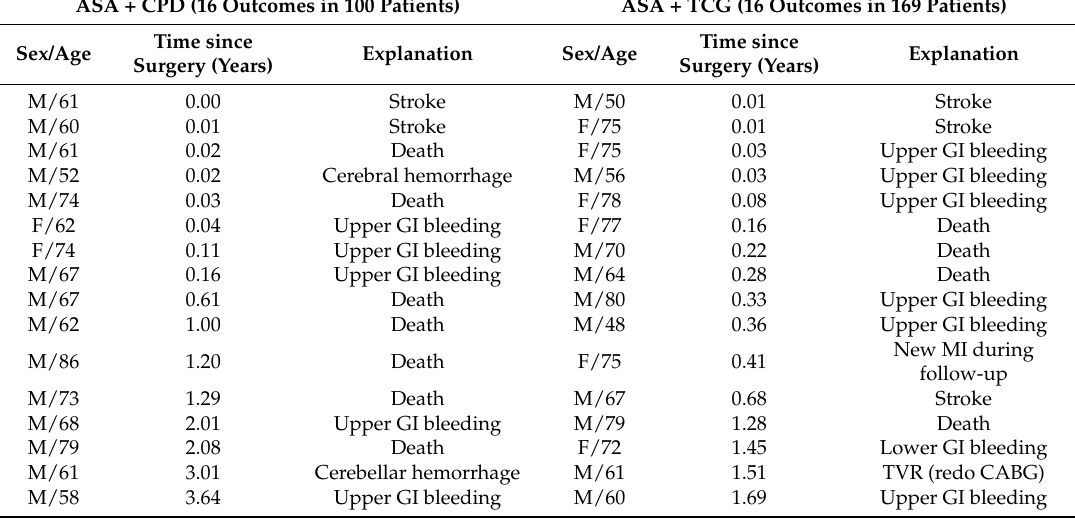
Figure 2. The reasons of continuing dual antiplatelet therapy (DAPT) after 3 months. Cardiologist preference: when the patients were followed-up by cardiologists and the latter decided to maintain DAPT after predetermined 3-month period. ASA, acetylsalicylic acid; CPD, clopidogrel; ICA, internal carotid artery; LV, left ventricle; PAOD, peripheral artery occlusive disease; TCG, ticagrelor. Table 3. List of patients with major adverse cerebrovascular and cardiovascular event (MACCE) or major bleeding. ASA + CPD (16 Outcomes in 100